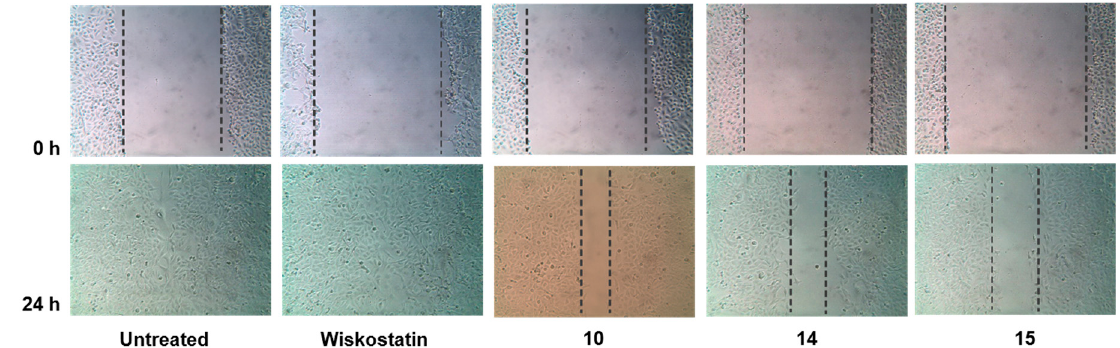
Figure 3. Inhibitory effect of compounds 10 , 14 , 15 , and Wiskostatin on MDA-MB-231 cells migration detected by wound-healing assay. MDA-MB-231 cells were treated with vehicle or with compounds 10 , 14 , 15 , and Wiskostatin. The photomicrographs were obtained at 0 and 24 h. Percent relative migration values are the average of three independent experiments. Dotted lines show the area occupied by the initial scraping for 0 h, and the wound edge for 24 h.